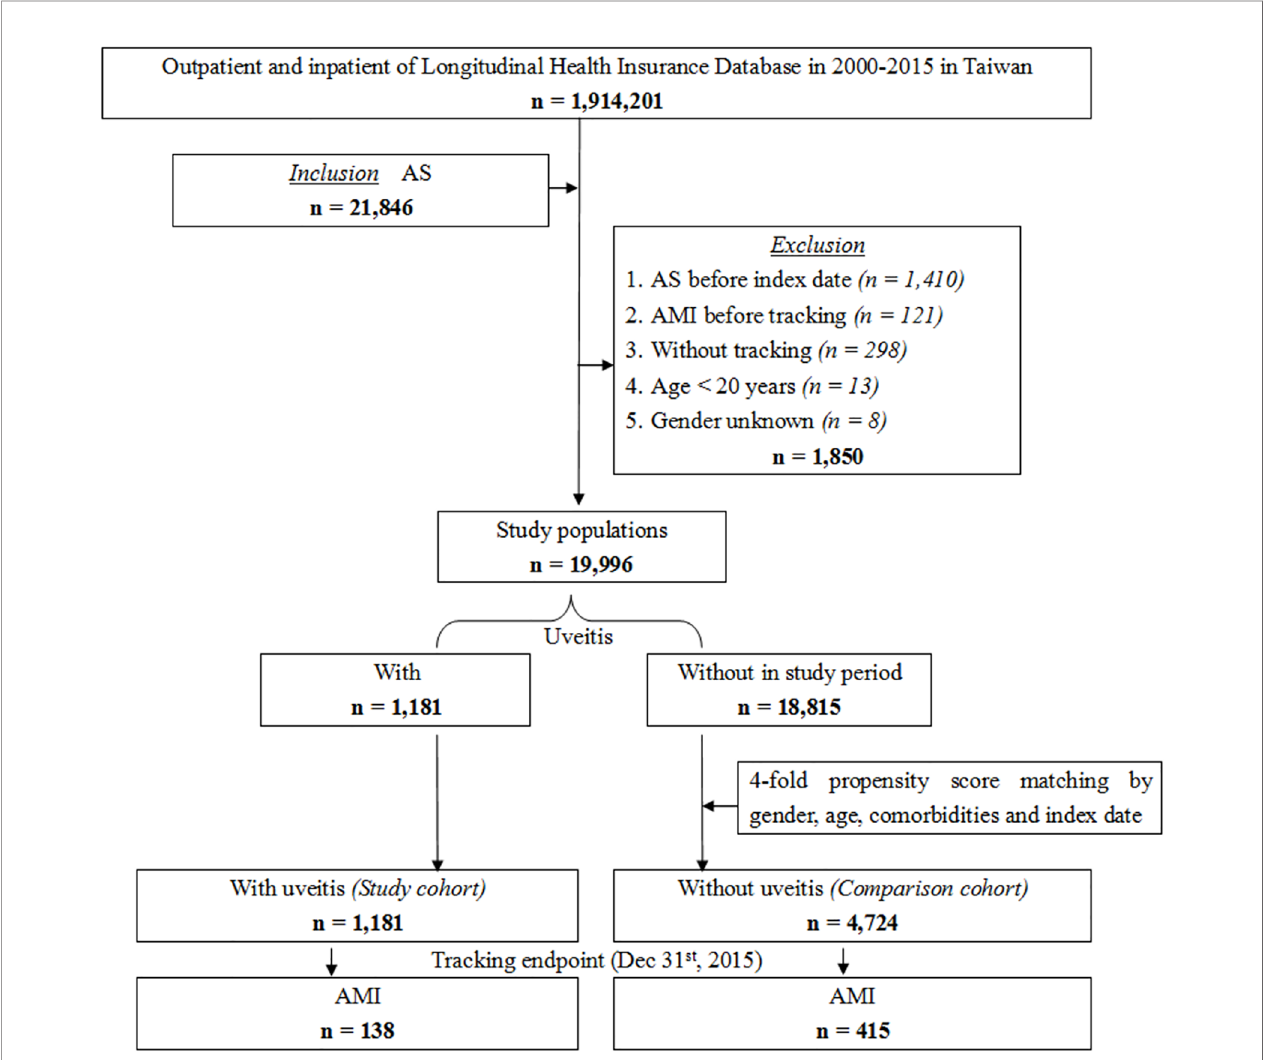
FIGURE 1 | Flowchart of patient selection from the National Health Insurance Research Database in